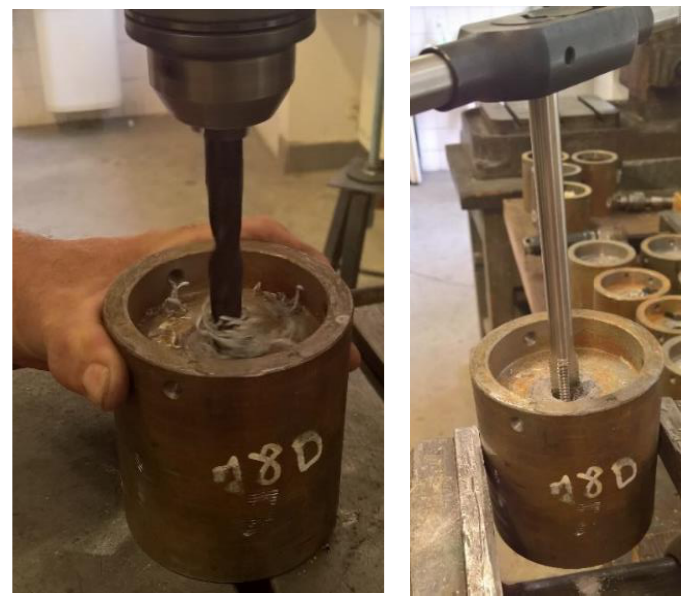
Figure 8. Steel base specimen restoration cleaning procedure.